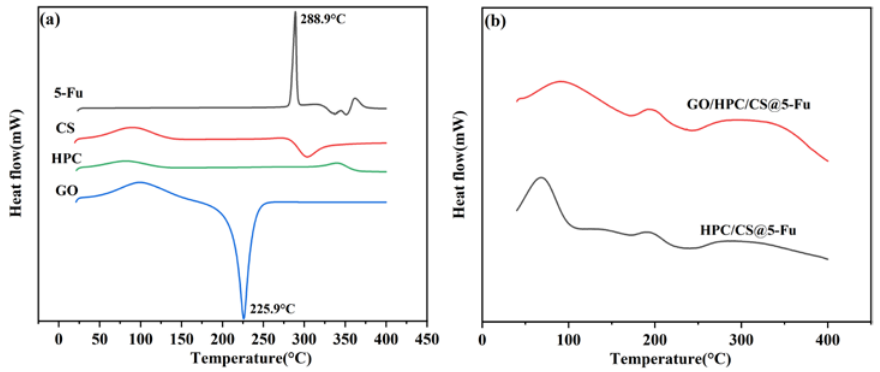
Figure 4. DSC curves of ( a ) raw material and ( b ) aerogels.